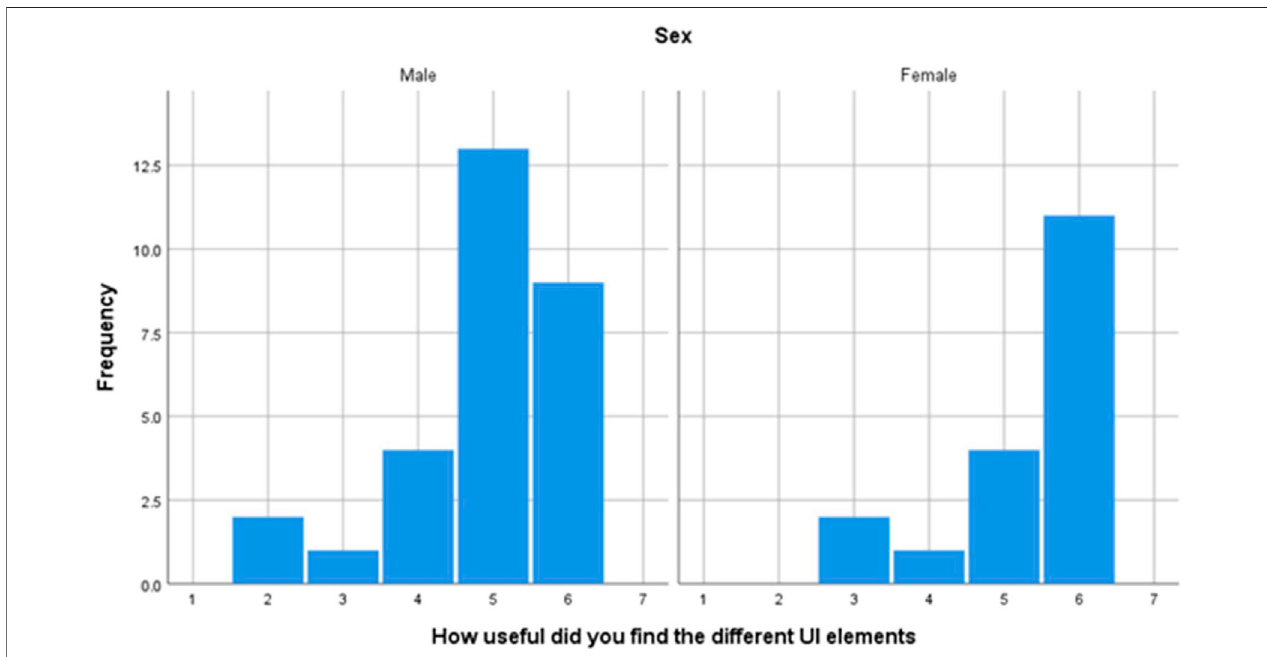
FIGURE 18 | Questionnaire participants results for how useful the onscreen user interface elements are.